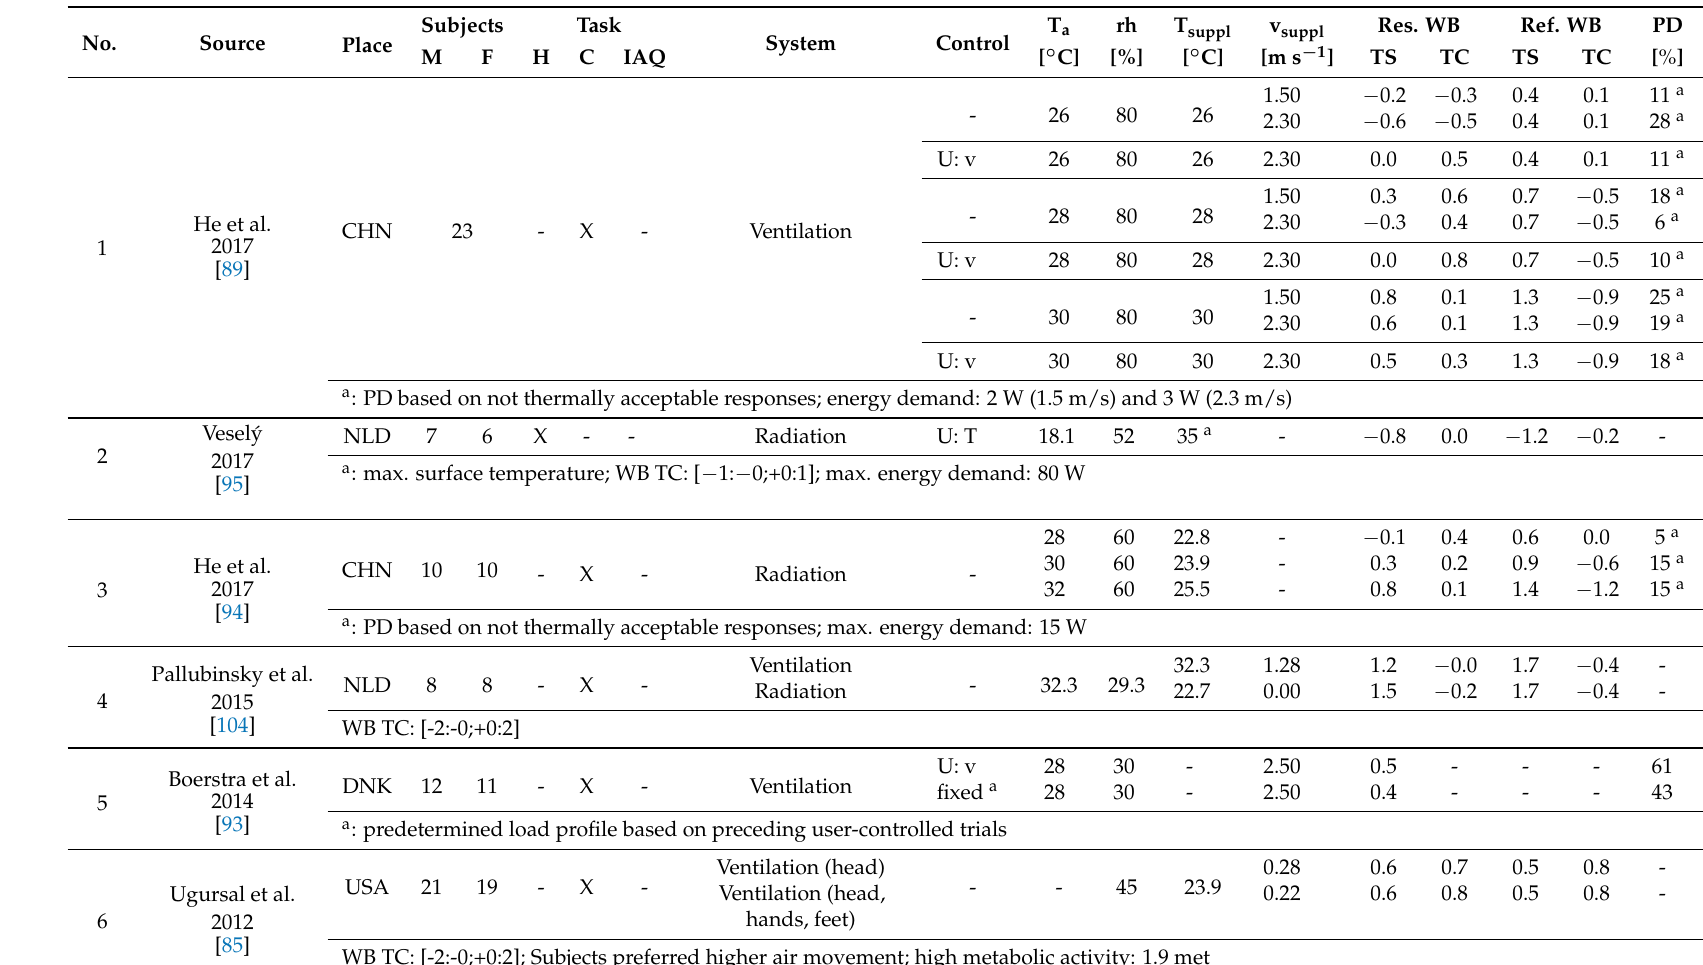
Table A1. Desk-mounted personal climatization systems (ventilation, radiation and